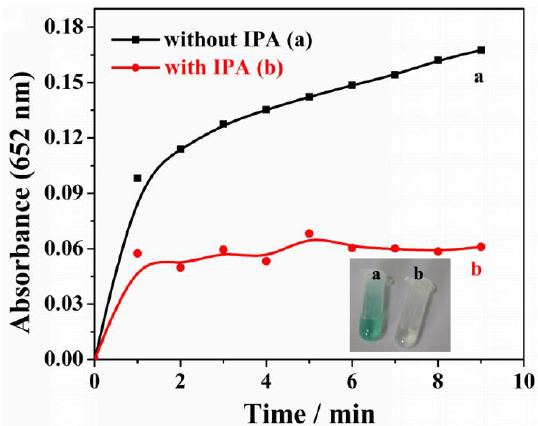
Figure 8. Time-dependent absorbance at 652 nm of the 0.4 mM TMB reaction solutions in the absence or presence of scavengers (IPA) in 20 mM PBS (pH = 3) with 20 μg/mL CF300 and 0.8 mM H 2 O 2 .